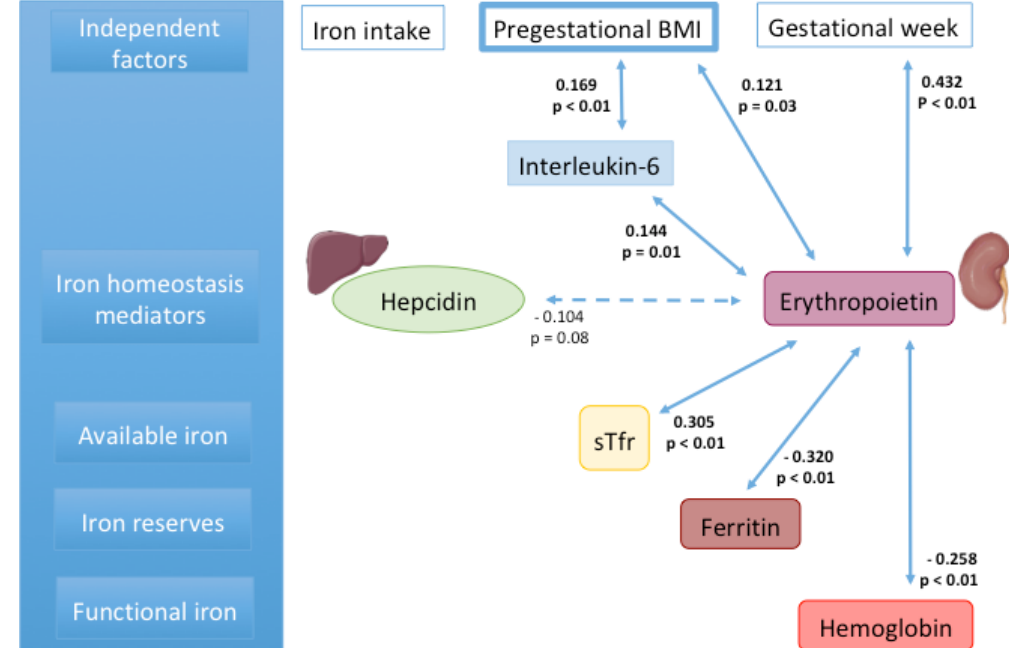
Figure 1. Bivariate associations. Pearson correlation among all variables (logarithmic transformation was used for variables with free distribution), r values and statistical significance are shown; continuous lines = p values < 0.05; dotted lines = p values between > 0.05 and < 0.1.